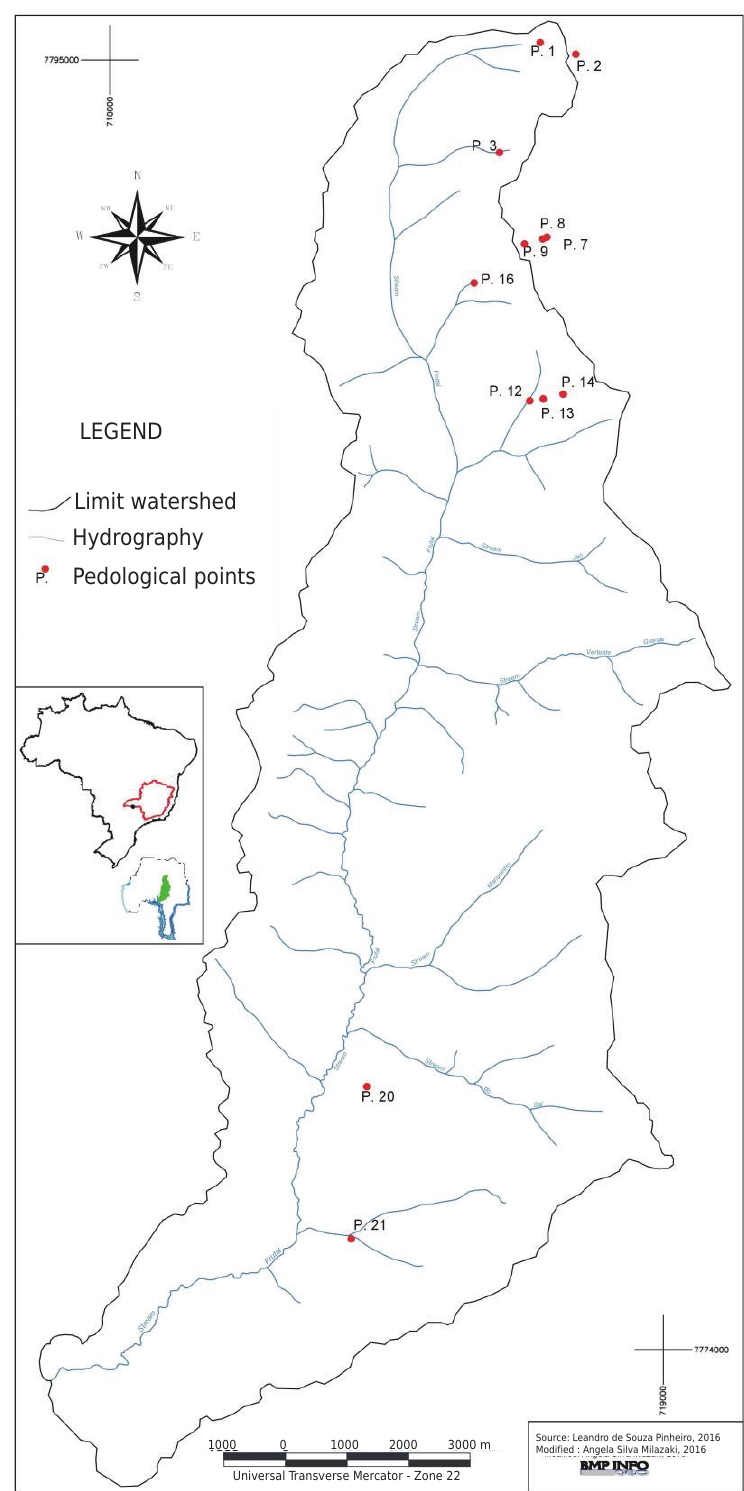
Figure 1. Watershed of the Riberão Frutal, located in the county of Frutal, State of Minas Gerais, Brazil.